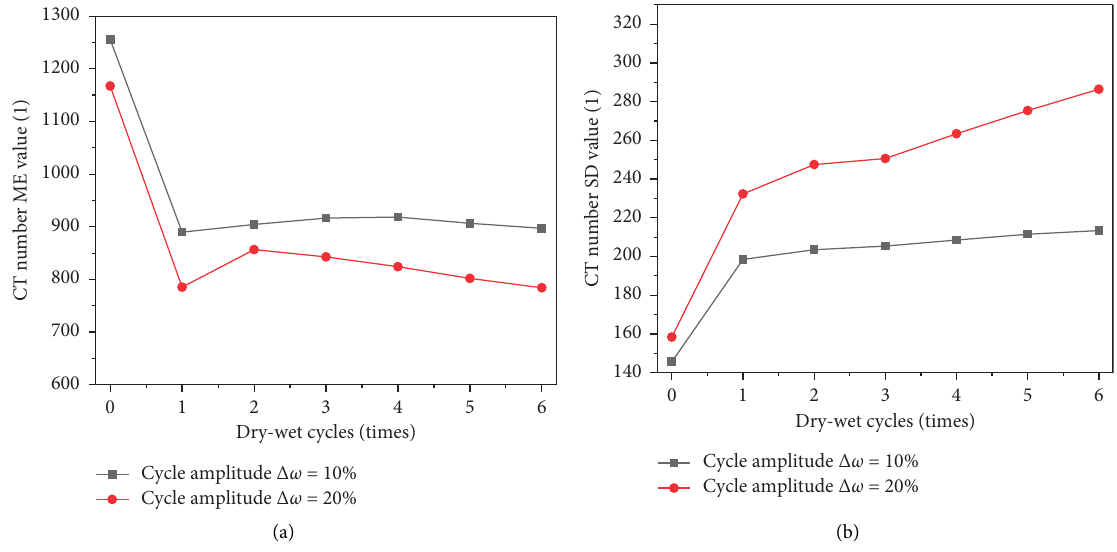
Figure 18: Relationship between the number of dry-wet cycles and CT number. (a) Change curve of CT number ME. (b) CT number SD